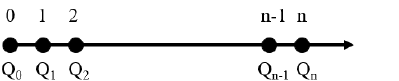
Figure 10. Schematic diagram of air leakage in the main cable.